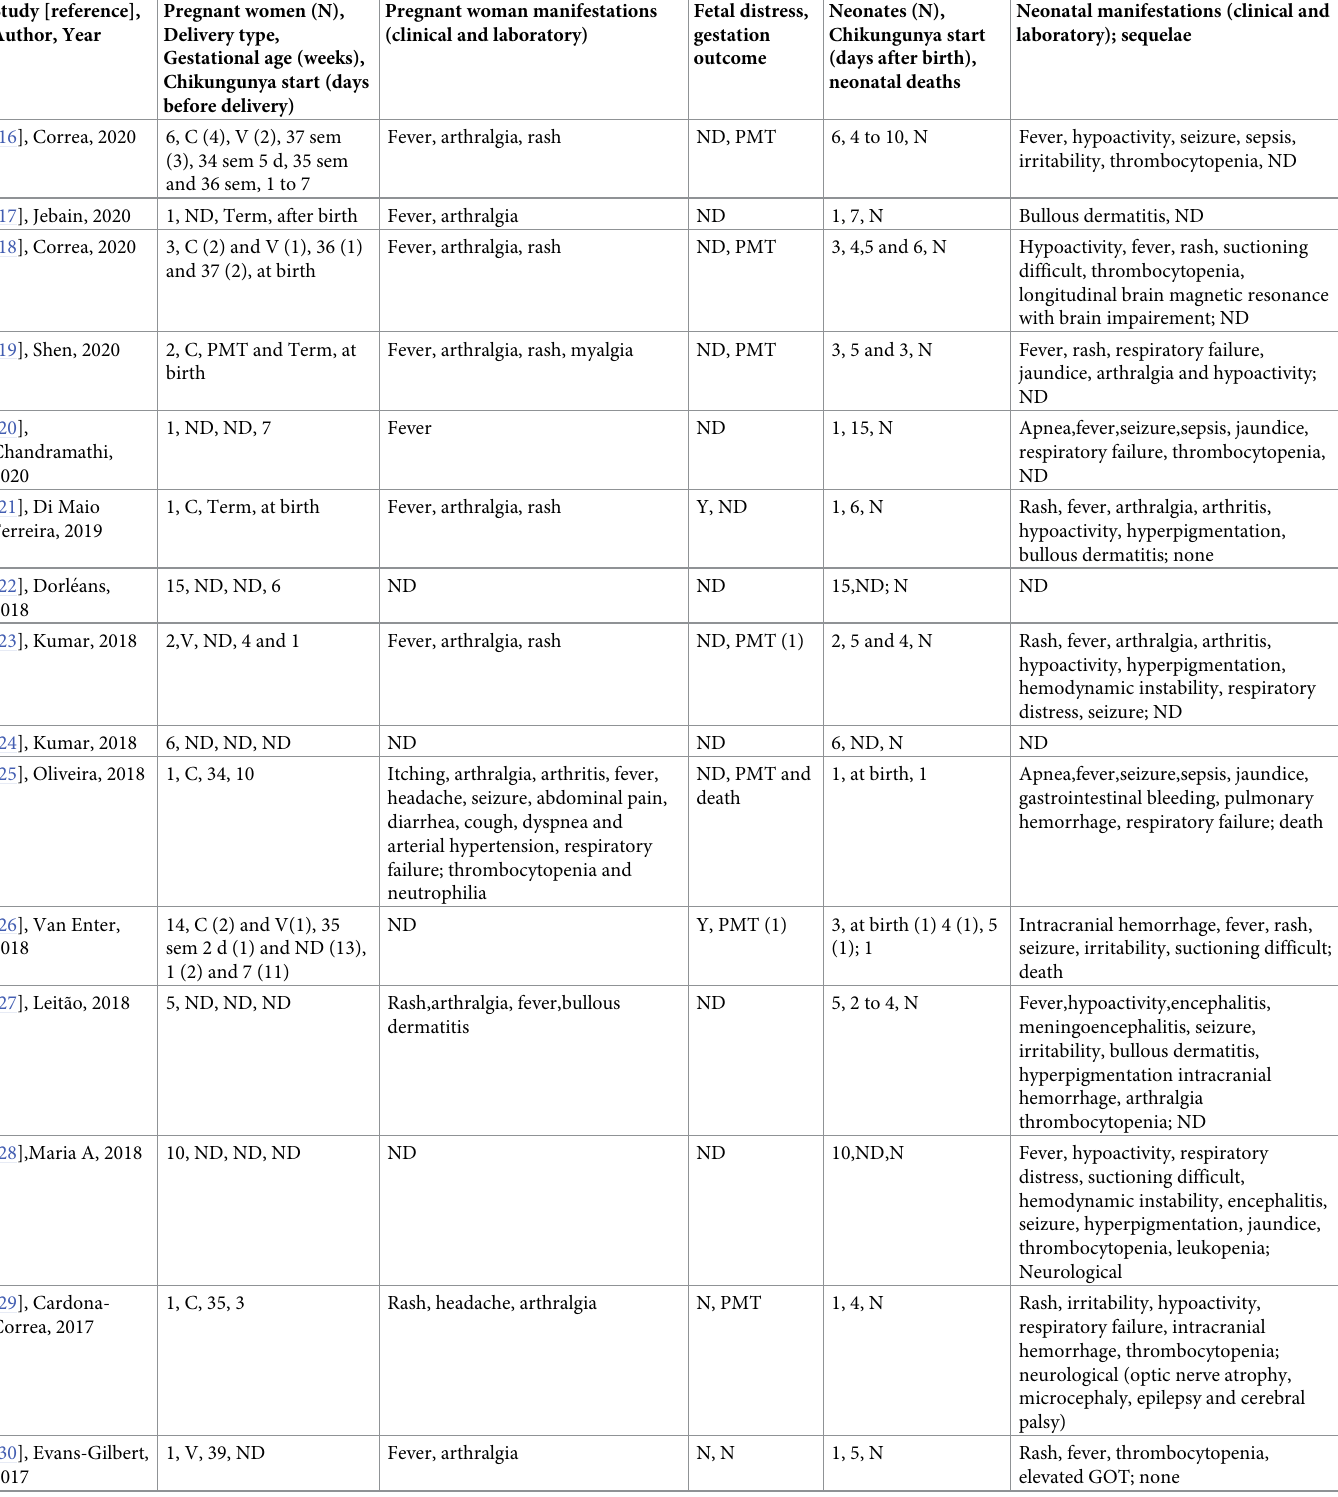
Table 2. Characteristics of pregnant women, neonates and their